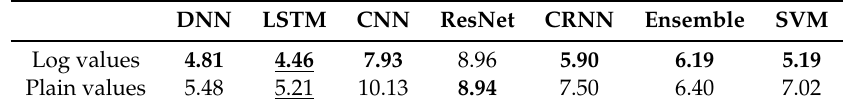
Table 7. Effect of using log values on regression (MAPE, %). The sequence size m = 20. The sequential partitioning and the first value-based normalization were used. DNN